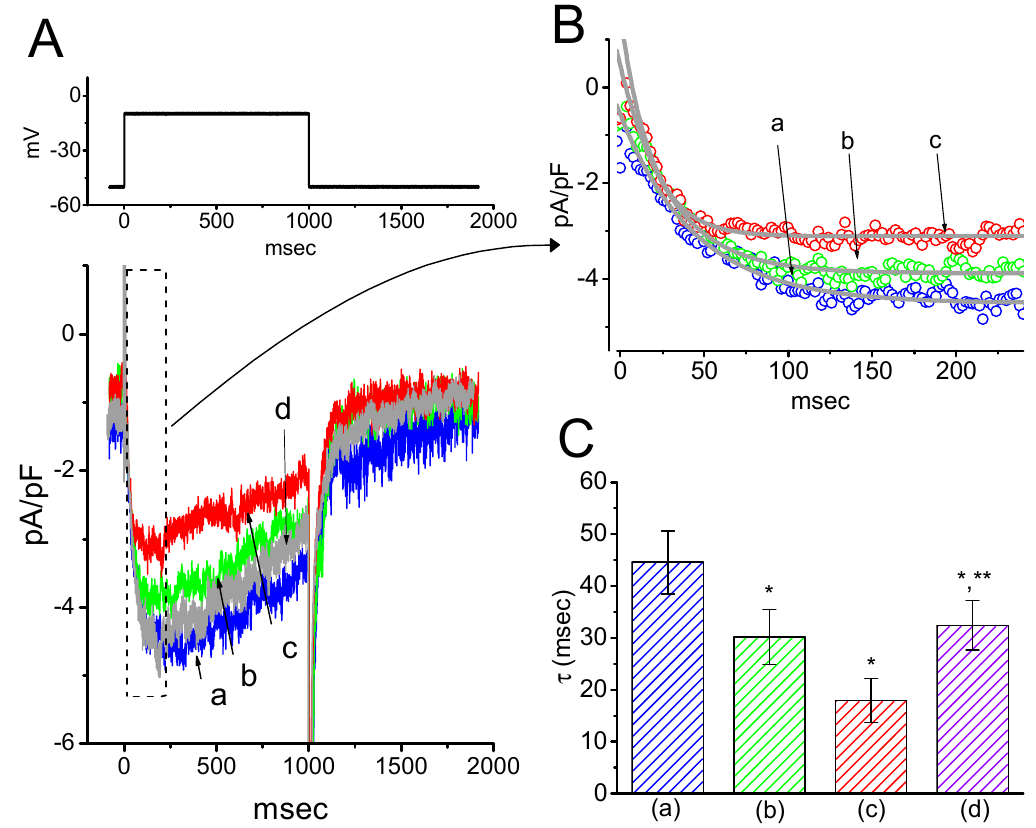
Figure 2. Inhibitory e ff ect of gastrodin (GAS) on I K(M) density in GH 3 cells. ( A ) Original traces of I K(M) density obtained with or without the addition of GAS. (a) control; (b) 10 µ M GAS; (c) 30 µ M GAS; (d) washout of 30 µ M GAS. ( B ) Expanded record from the dashed box in (A), indicating the e ff ect of GAS on the activation time course of the I K(M) -density trajectory as elicited by membrane depolarization. Each current trajectory was least-squares fitted by a single exponential (indicated by the smooth line) with a τ act of 44.6 ms (a) in the absence of GAS, 30.1 ms (b) in 10 µ M GAS, and 17.9 ms (c) in 30 µ M GAS. ( C ) Summary bar graph showing the e ff ect of GAS and GAS plus flupirtine on the τ act value of I K(M) -density trajectory in response to membrane depolarization (mean ± SEM; n = 9–11 for each bar). (a) control; (b) 10 µ M GAS; (c) 30 µ M GAS; (d) 30 µ M GAS plus 10 µ M flupirtine. * p < 0.05 vs. the control. ** p < 0.05 vs. (c) 30 µ M